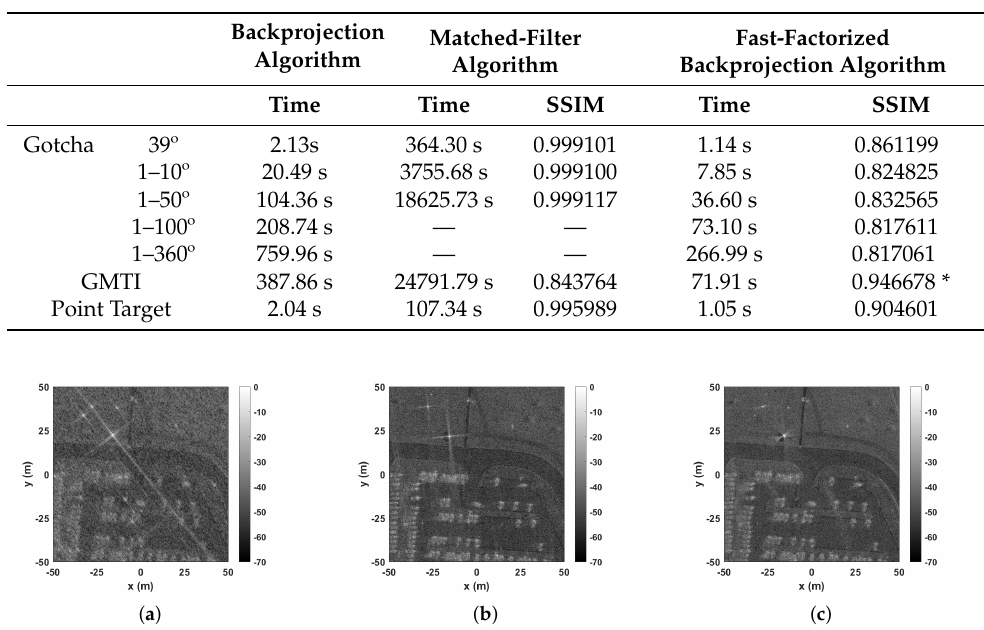
Figure 9. Images generated using the matched filter algorithm and the Gotcha Volumetric SAR dataset at different azimuth angles: 39º, 1–10º and 1–50º. Due to the computational complexity of the algorithm, larger ranges were not generated, since they would take days. ( a ) GOTCHA